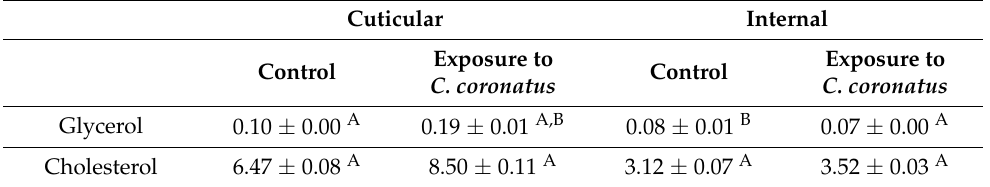
Table 6. Other compounds extracted from Sarcophaga argyrostoma adults (μg/g of insect body ± SD). Cuticular